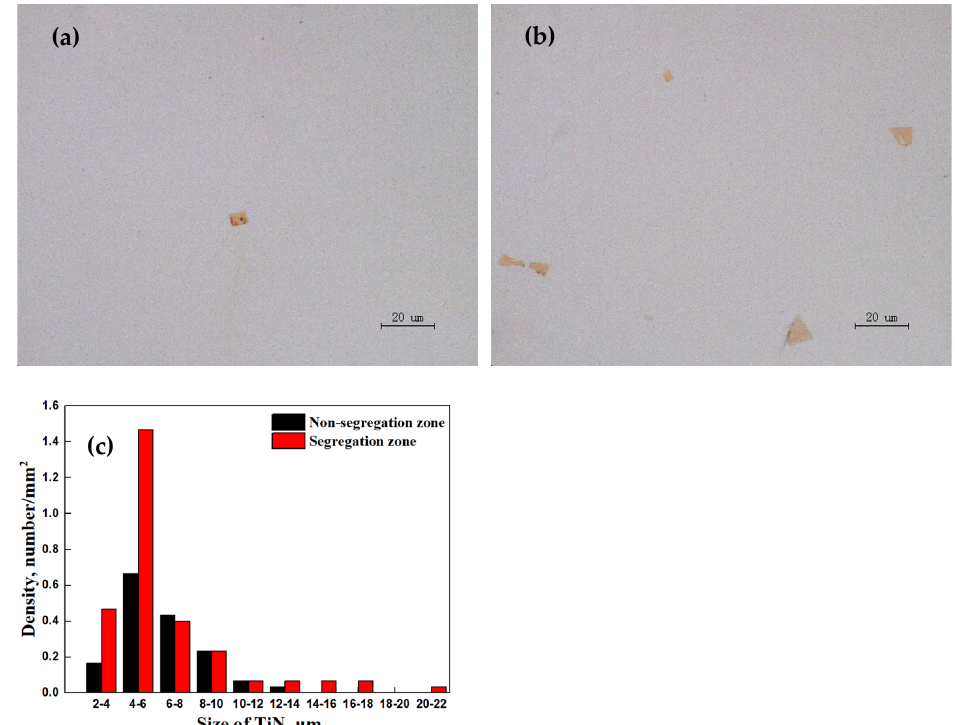
Figure 7. Optical microscopy images and size distribution of the TiN inclusions. ( a ) Non-segregation zone, ( b ) segregation zone and ( c ) size distribution of the TiN.